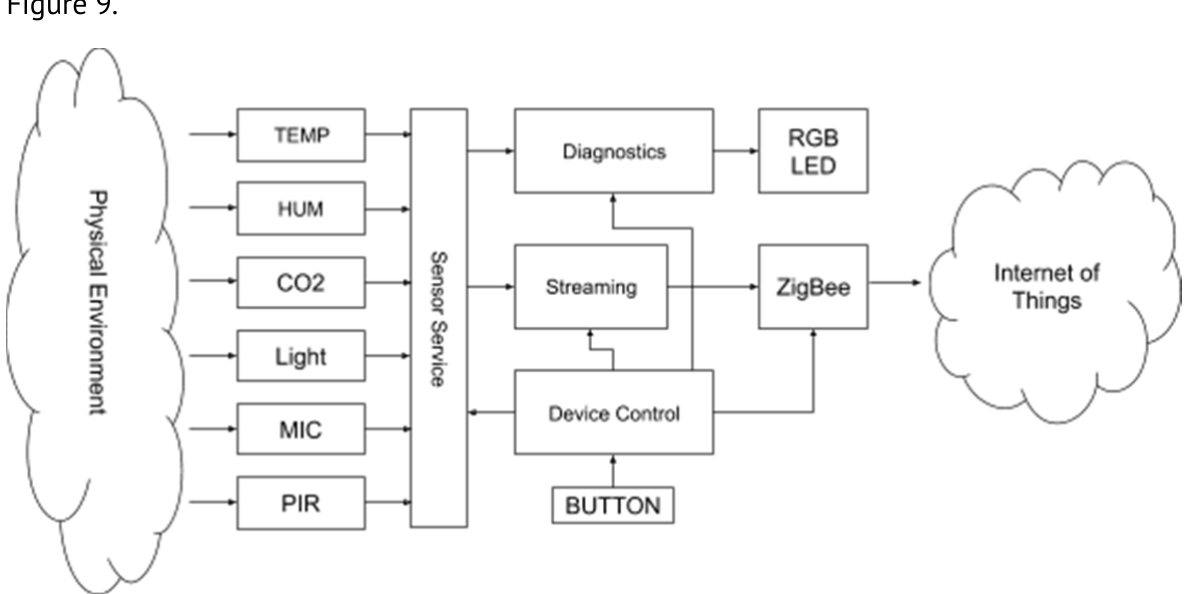
Figure 9. Functional & dataflow diagram for the IoT device.